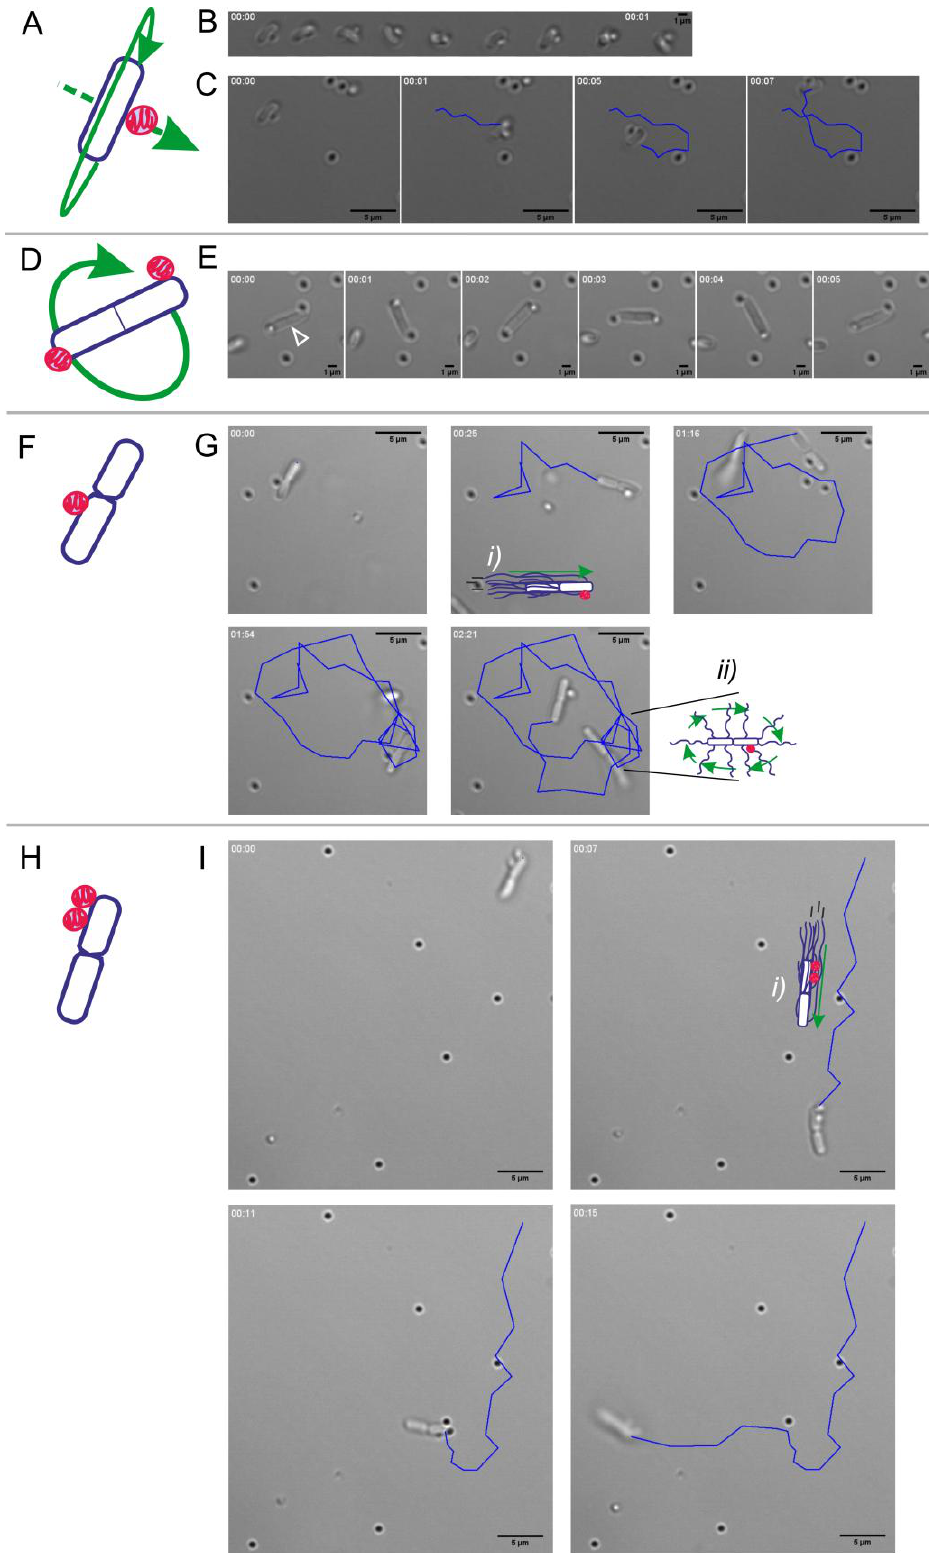
Figure 5. Natural variations in B. subtilis W168 biohybrid microswimmers designs. ( A – C ), schematics ( A ) and optical microscopy ( B , C ) of a biohybrid composed by 1 bacterium:1 cargo rotating over long axis of the cell while moving forward. ( B ), time lapse of the bacterial movement pushing the cargo. ( C ), time lapse of the biohybrid trajectory. The images correspond to Video S2 in the Supplemental Material. ( D , E) , schematics and optical microscopy of a dividing bacteria with two cargoes in opposite sites rotating over long axis (Video S3 in Supplementary Materials). The incipient septum is indicated